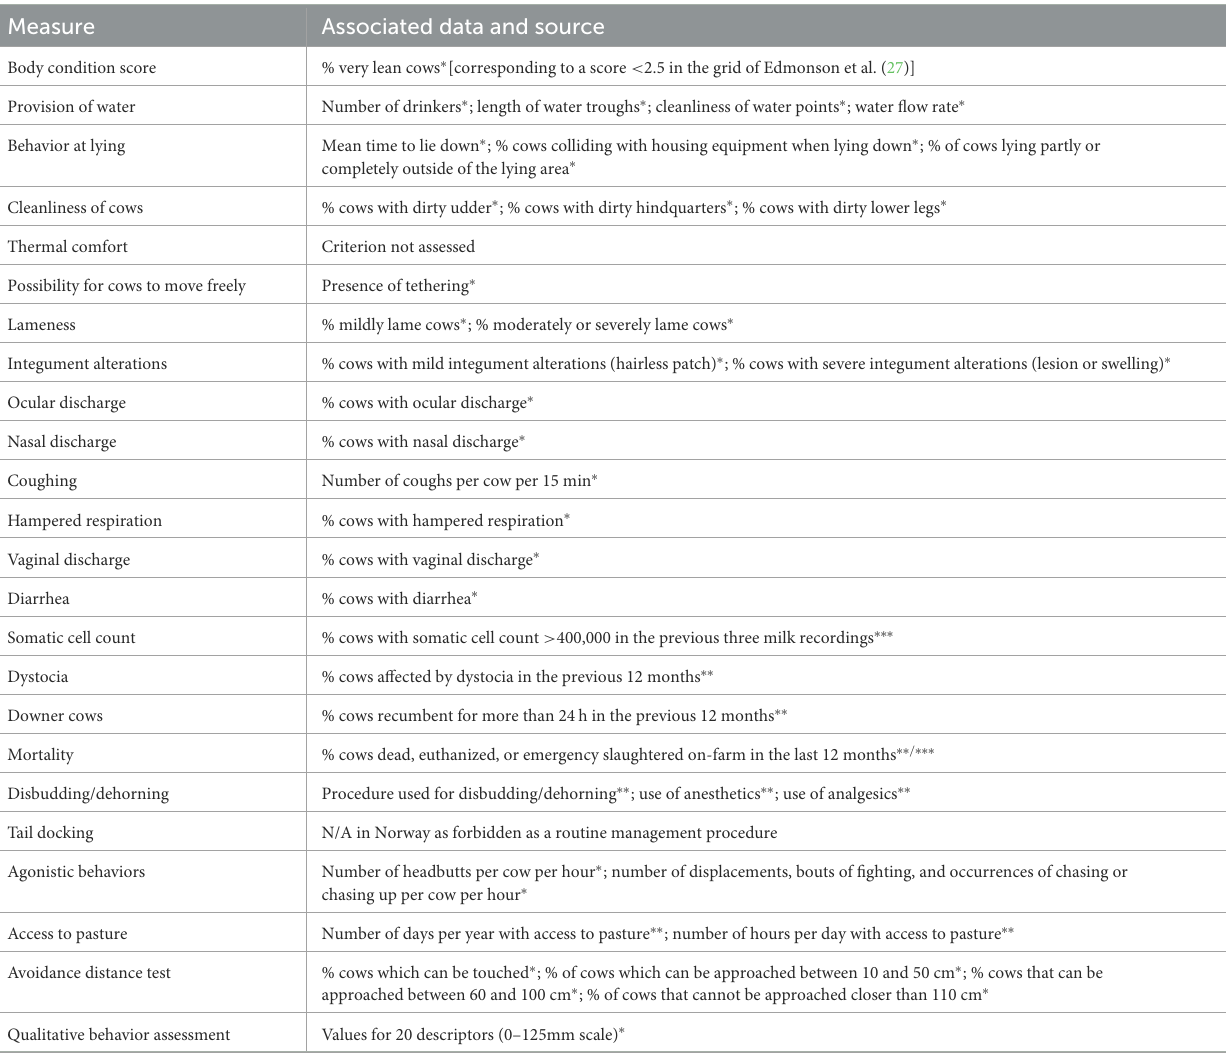
TABLE 2 Summary of the data collected for each measure of the Welfare Quality ® protocol and the sources of the data ( ∗ on-farm observation or clinical assessment; ∗∗ interview with farmer or livestock manager; ∗∗∗ Norwegian Dairy Herd Recording System). Measure Associated data and source Body condition